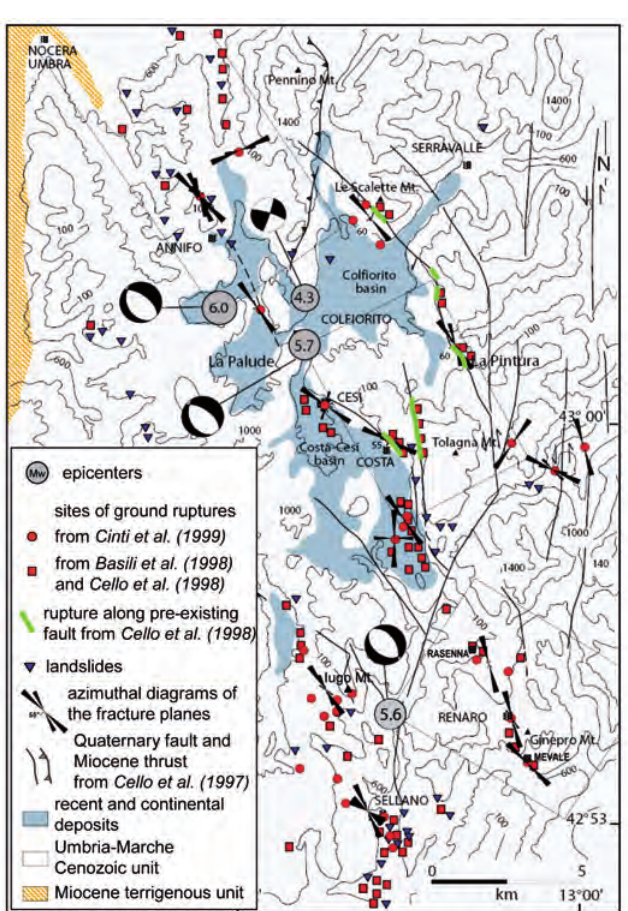
Fig. 4. Map showing a synthesis of the coseismic ground ruptures sites from the different teams (modified by Cinti et al ., 2000). The rose diagrams show the azimuth of fracture planes (some of them refer to multiple sites) and the dip of the planes where observed (from Cinti et al. , 2000). Dotted rectangles indicate the upward pro- jection of the mainshocks rupture planes (Capuano et al . 2000; Hunstad et al . 1999; Salvi et al . 2000; Amato et al .,